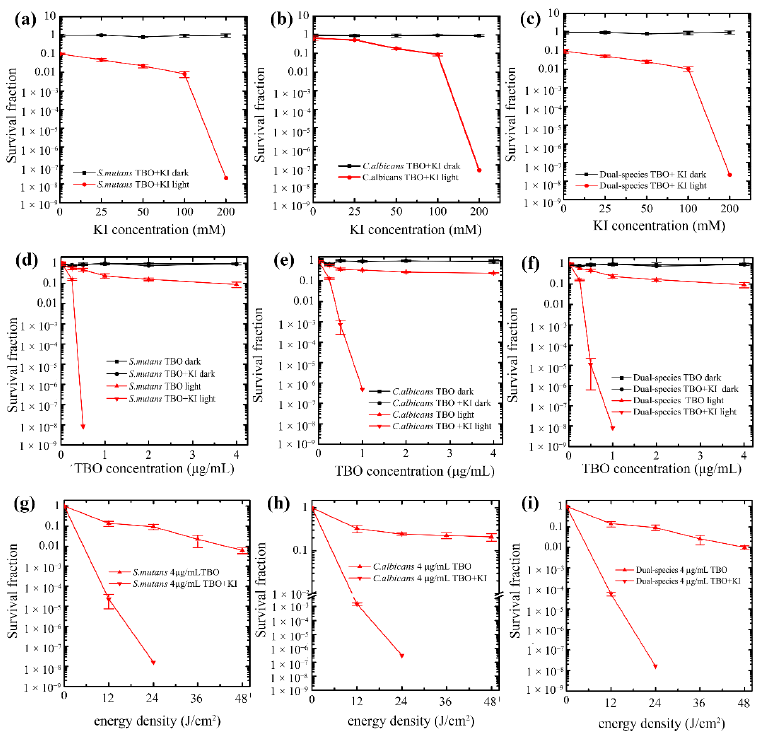
Figure 2. Antimicrobial effect of different concentrations of KI on toluidine blue O (TBO)-mediated antimicrobial photodynamic therapy (aPDT) on microorganisms in plaque suspension. The survival curves of ( a ) S. mutans , ( b ) C. albicans, and ( c ) total microorganisms. Antimicrobial effect of different concentrations of TBO with or without KI on microorganisms in plaque suspension. The survival curves of ( d ) S. mutans , ( e ) C. albicans , and ( f ) total microorganisms. Antimicrobial effect of different light doses on microorganisms in plaque suspension. The survival curves of ( g ) S. mutans , ( h ) C. albicans , and ( i ) total